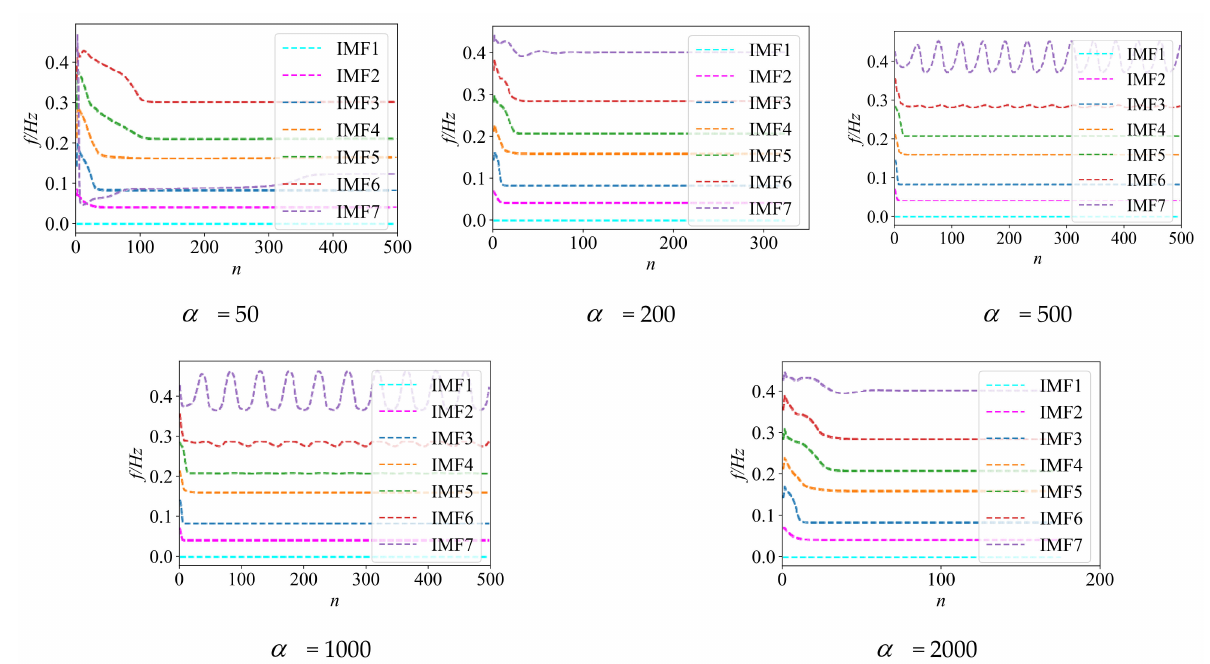
Figure 2. Sample center frequency iteration curves in different penalty